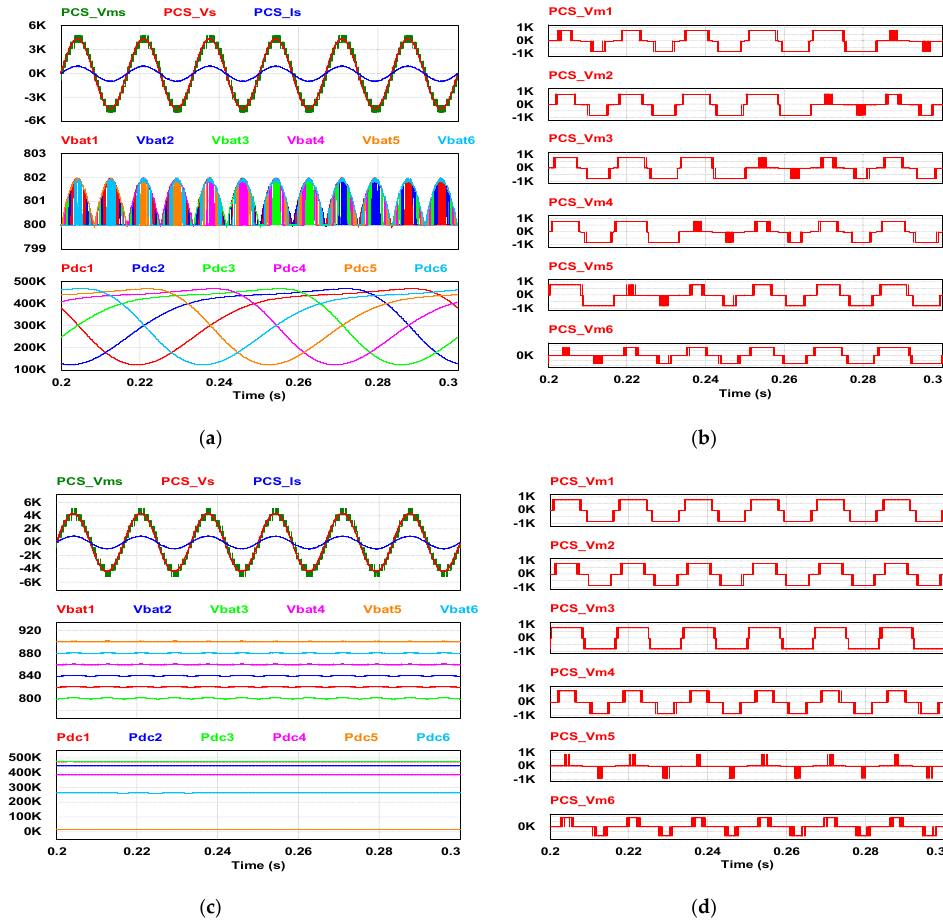
Figure 16. Battery balancing mode simulation results: ( a ) Reference period rotation (RPR) mode, ( b ) respectively cell inverter output voltage at RPR mode, ( c ) adapted select switch (ASS) mode output and ( d ) respectively cell inverter output voltage at ASS mode.